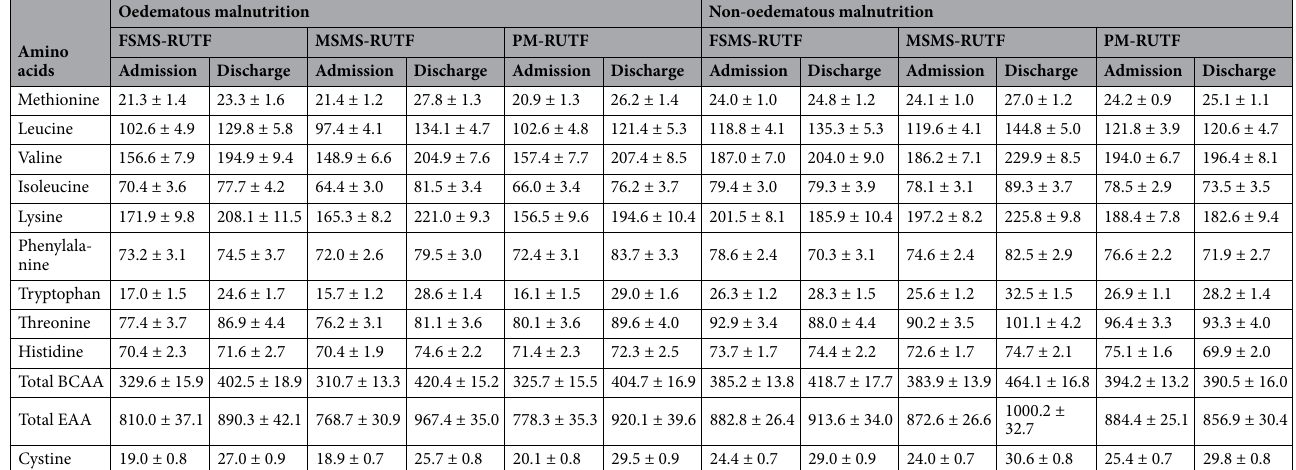
Table 2. Predicted plasma amino acid concentrations (μM) in each SAM subgroup. Plasma amino acid concentrations were predicted from a mixed model with a random intercept by using oedematous and non-oedematous malnutrition subgroup data. Fixed effects were intervention (RUTFs) and sampling point (admission or discharge). The model was adjusted for the admission values and random effects of the sub- administrative areas. Predicted concentrations are expressed as the means ± SEs (μM). All specimens described as “Analysis” in Fig. 2 were used for this